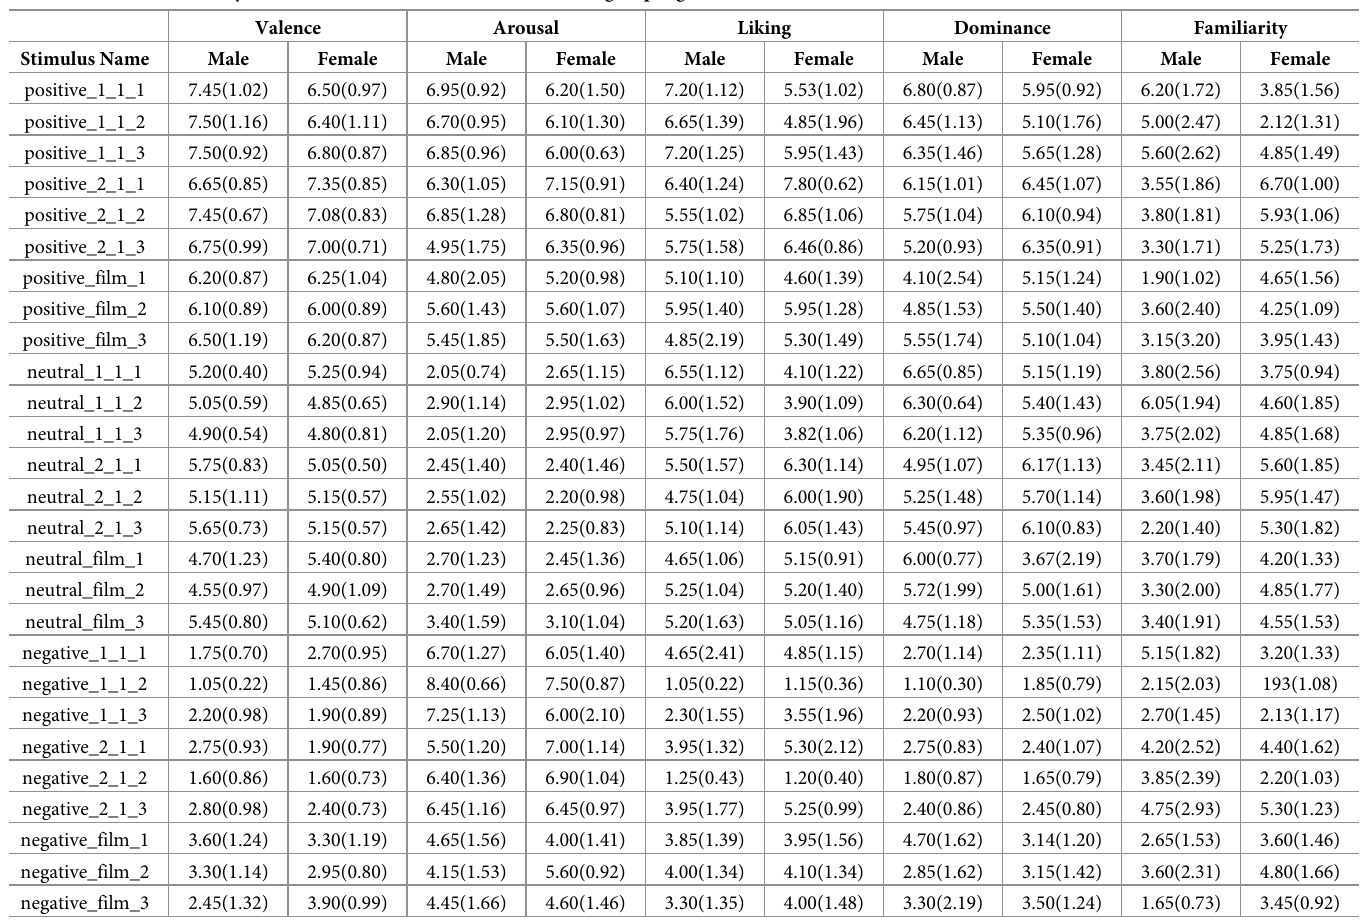
Table 5. The statistical analysis results on SAM scale of male and female groups aged